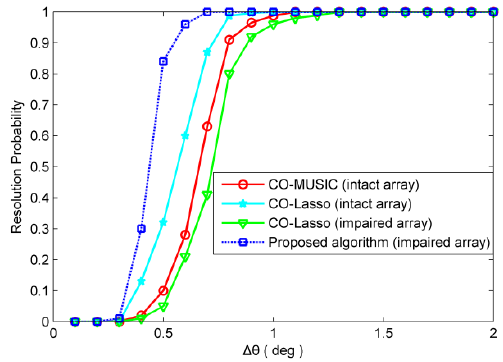
Figure 9. The scenario of non-redundant sensor failures, resolution probability versus θ . Two sources are set to θ 1 = 30 and θ 2 = θ 1 + θ . The snapshot number is 300 with SNR = 0 dB.